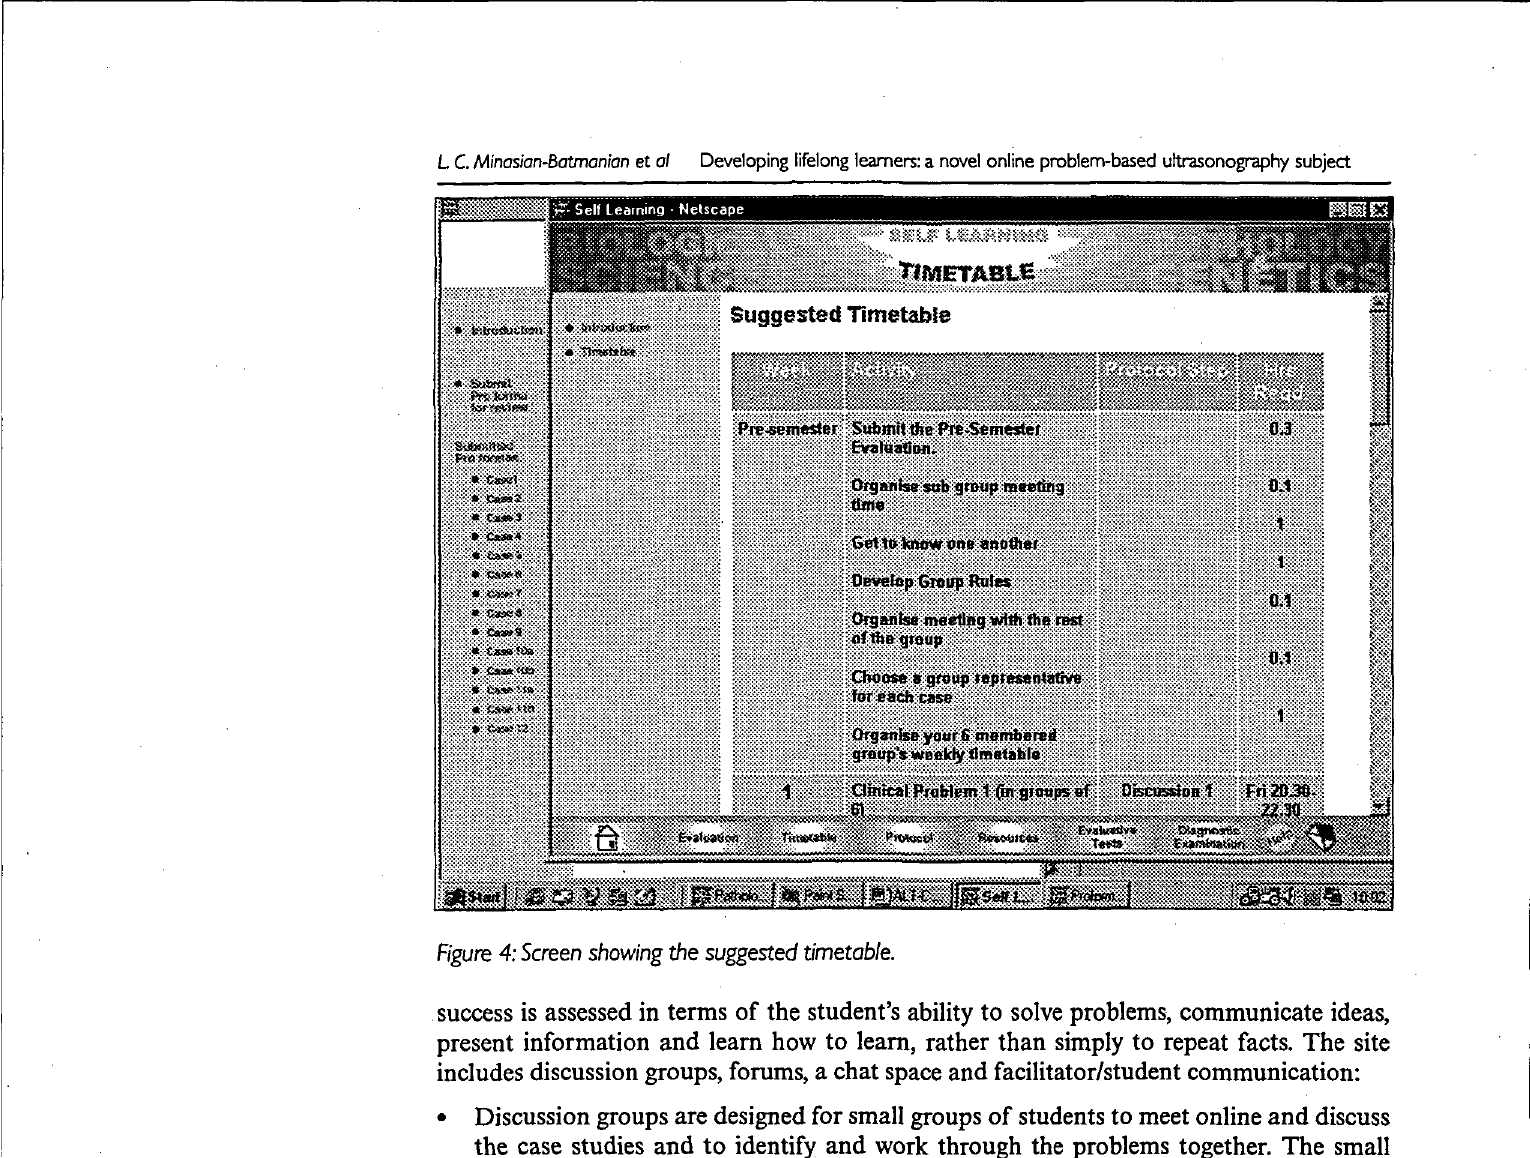
Figure 4: Screen showing the suggested